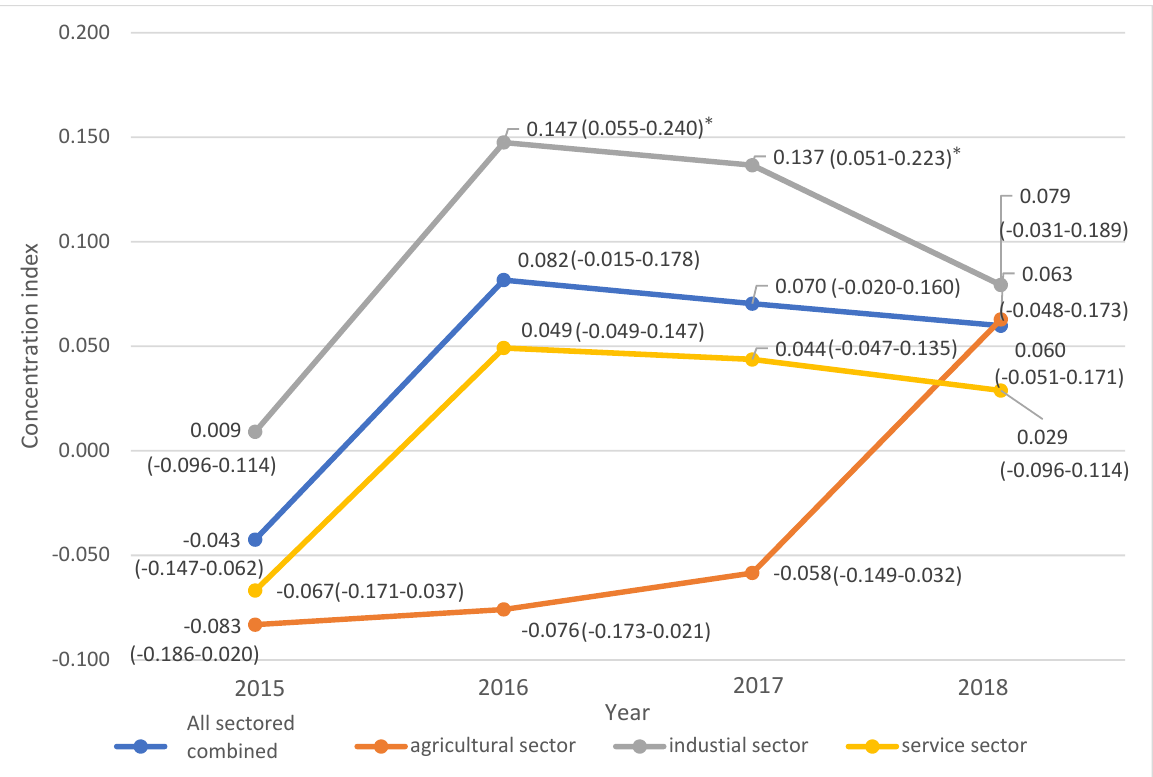
Figure 5. Showed the trend of concentration index in agricultural, industrial, and service sectors and total migrants by year 2015 to 2018. * Statistical Significance above 99% confidence level.